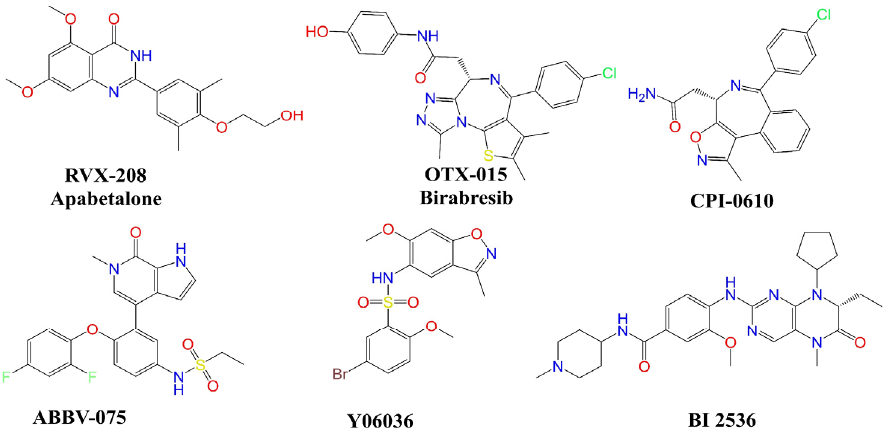
Figure 2. Chemical structures of selected BRD-4 inhibitors.